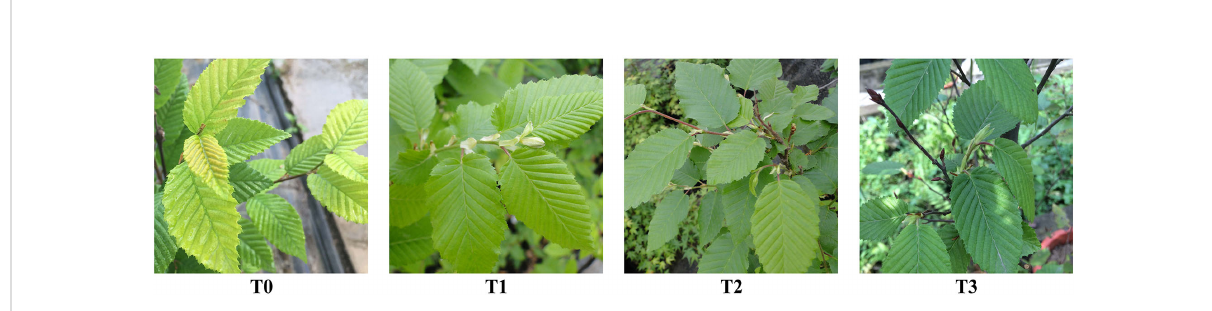
FIGURE 1 The growth of the leaves of C. betulus seedlings under different light intensity (T0~T3) after 60